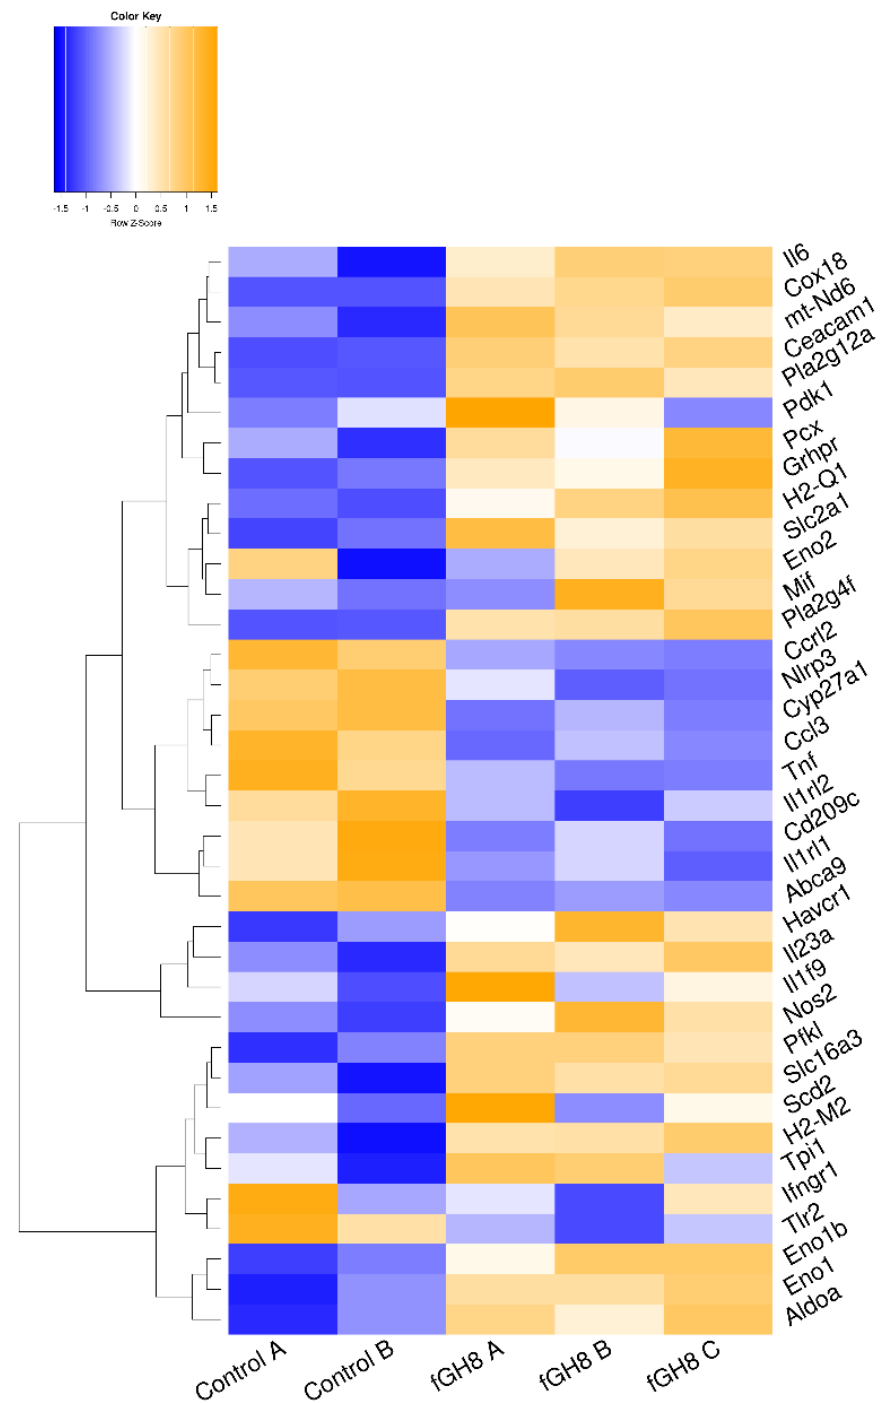
Figure 6. Unsupervised hierarchical clustering based on expression of metabolism-related DEGs between fGH8 versus Control BMDCs.